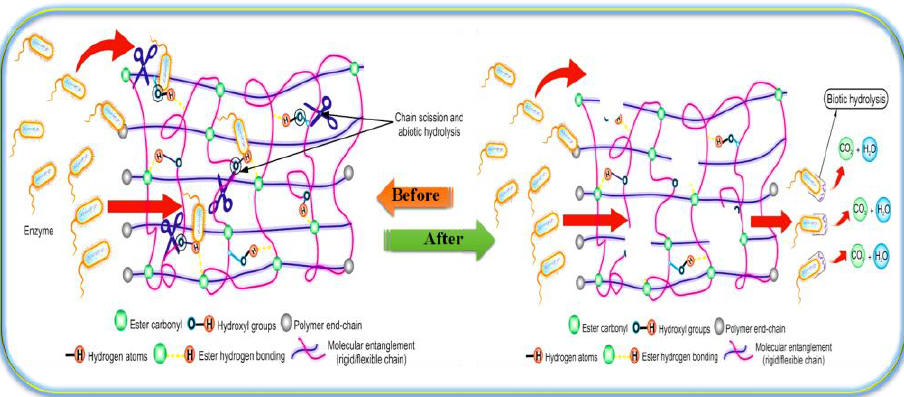
Figure 11. Degradation mechanisms of poly(ether-ester)s.